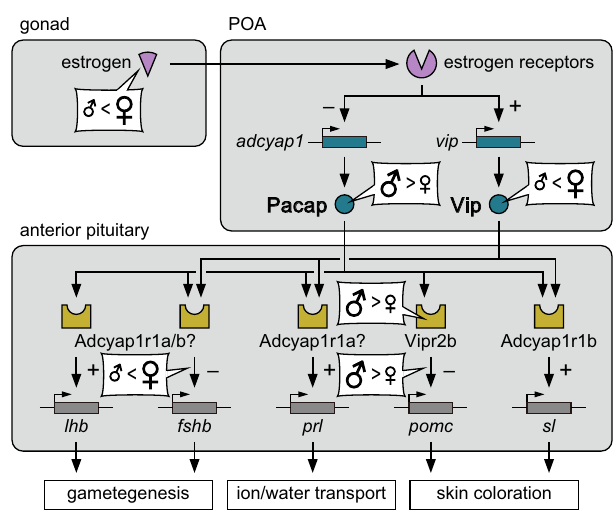
Fig. 9 Schematic summary illustrating that males and females, respectively, use Pacap and Vip in the POA to control the production of anterior pituitary hormones. Estrogen secreted by the gonad in adulthood attenuates Pacap expression and, conversely, stimulates Vip expression in the hypophysiotropic population of POA neurons, thereby establishing and maintaining their opposite sexual dimorphism. Both Pacap and Vip have sex-independent stimulatory effects on expression of prl and sl , and female- speci fi c inhibitory effects on fshb . Pacap additionally exerts sex-independent stimulatory effects on lhb and male-speci fi c inhibitory effects on pomc